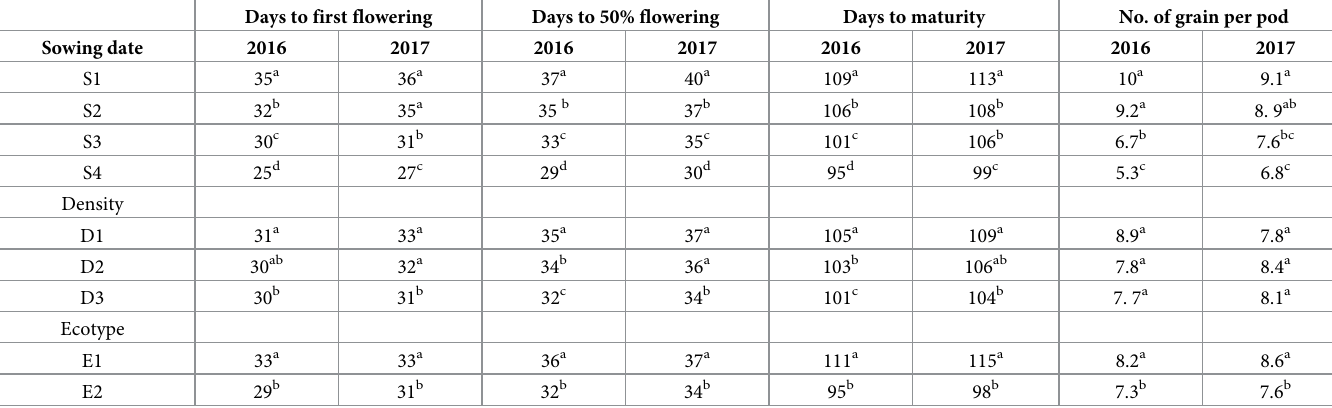
Table 4. Guar phenology, and number of grains per pod traits affected by sowing date, plant density and ecotype. Days to first